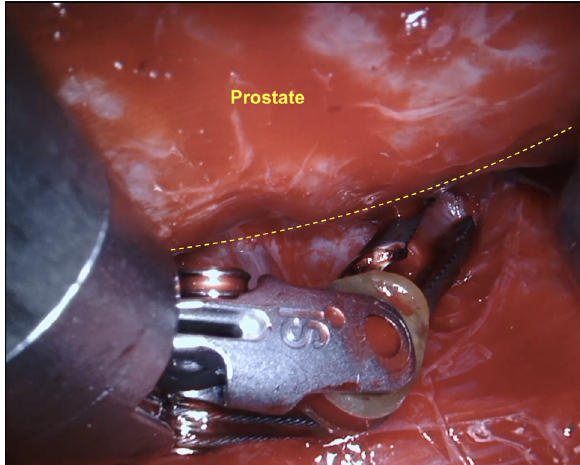
Figure 3 - Scope facing the posterior aspect of the prostate (30-degrees up), achieving the optimal anatomical visualization necessary to release the NVB on both sides.